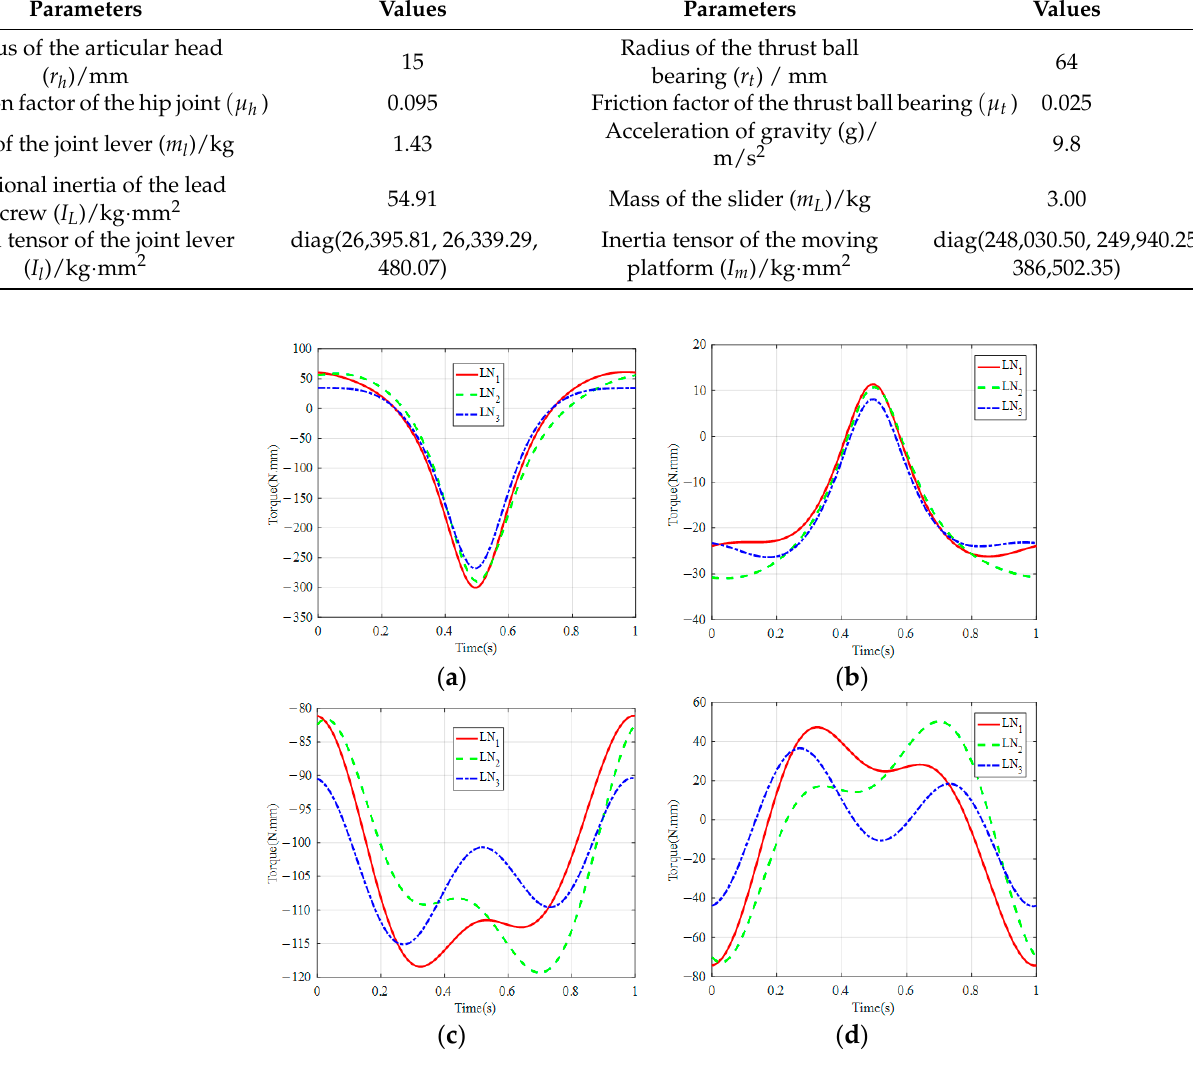
Figure 8. Contributions of each part to the input torques. ( a ) Moving platform; ( b ) Joint lever; ( c ) Slider; ( d ) Lead screw.